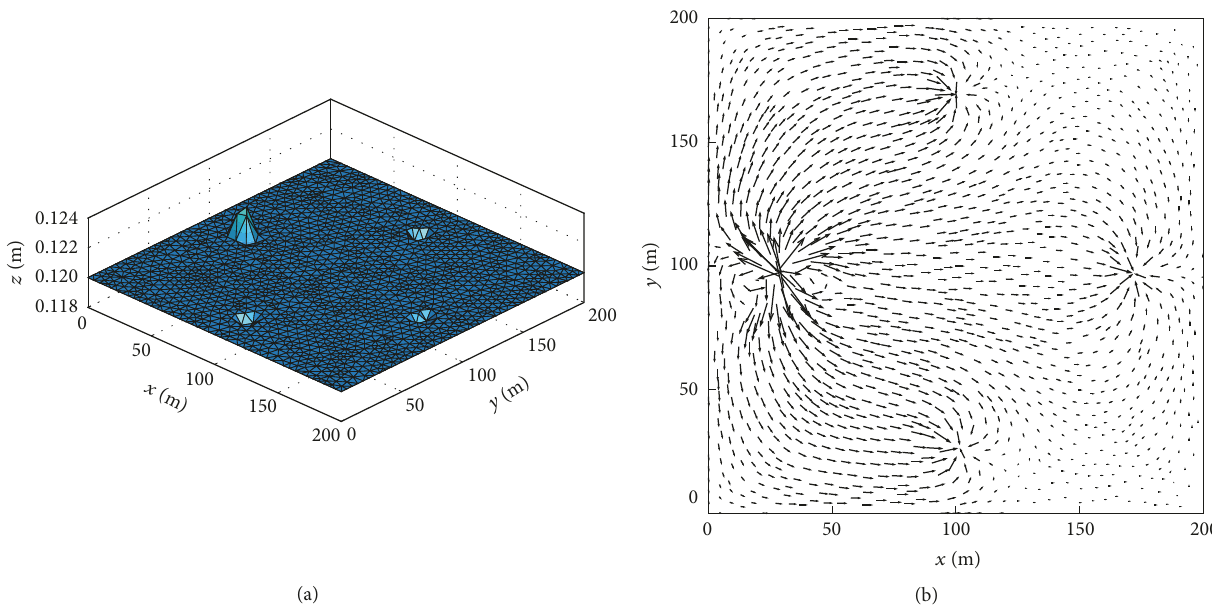
Figure 10: Distribution of flow field and water level in the floodplain: (a) water level; (b) flow field.